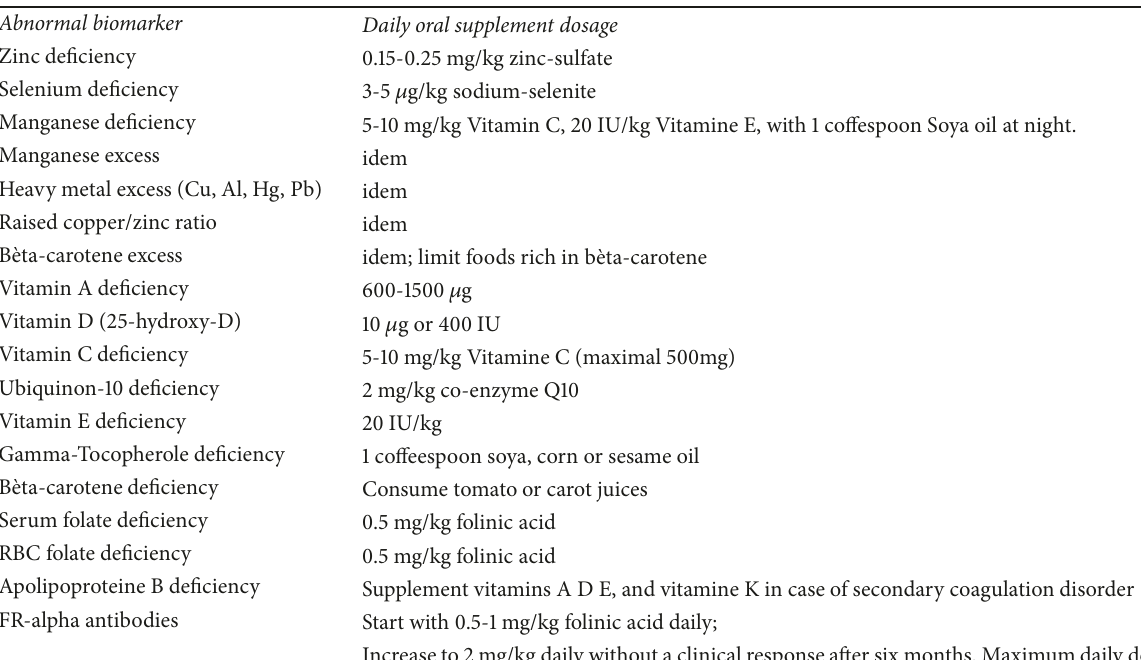
Table 1: The treatment protocol for the self-controlled treatment trial based upon abnormal biochemical findings and FR 𝛼 autoantibodies. Abnormal